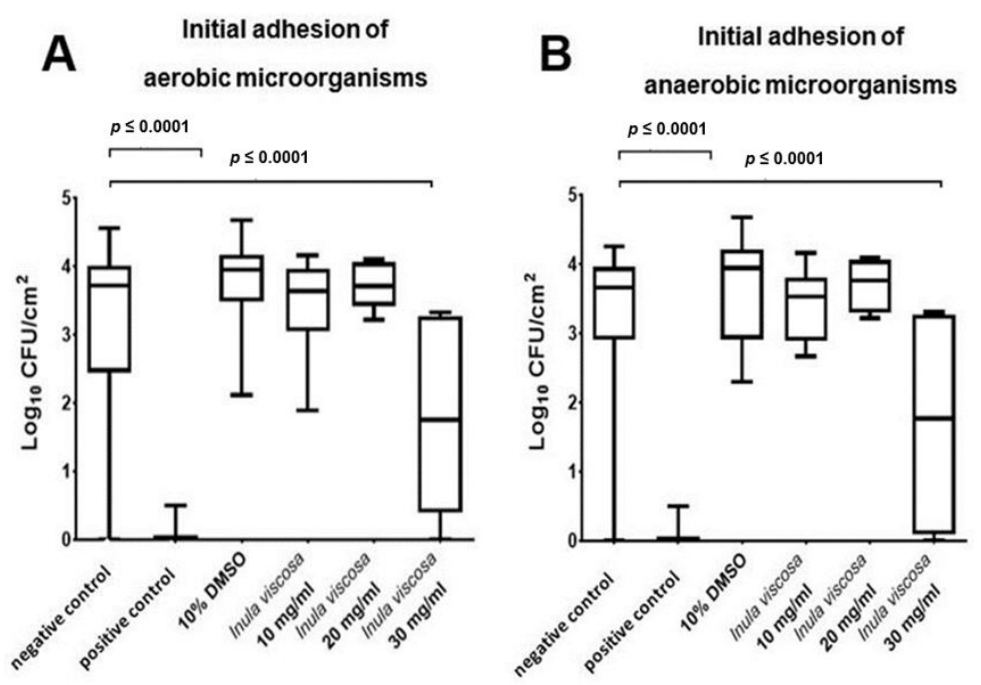
Figure 2. The graphs show the number of CFUs that demonstrate the antimicrobial effect of the tested substances on aerobic ( A ) and anaerobic ( B ) bacteria after an oral exposure time of two hours. An untreated negative control (NaCl 0.9%), a positive control (CHX 0.2%), and a control with DMSO (10%) were also used, as was the natural I. viscosa extract (10, 20, and 30 mg/mL) with a 10 min exposure time. The CFU values were shown on a log 10 scale per cm 2 (log 10 /cm 2 ). The box shows the area in which the middle 50% of the data lies. The line dividing the box shows the median. The p- values of the significantly different data are marked on the graphs.